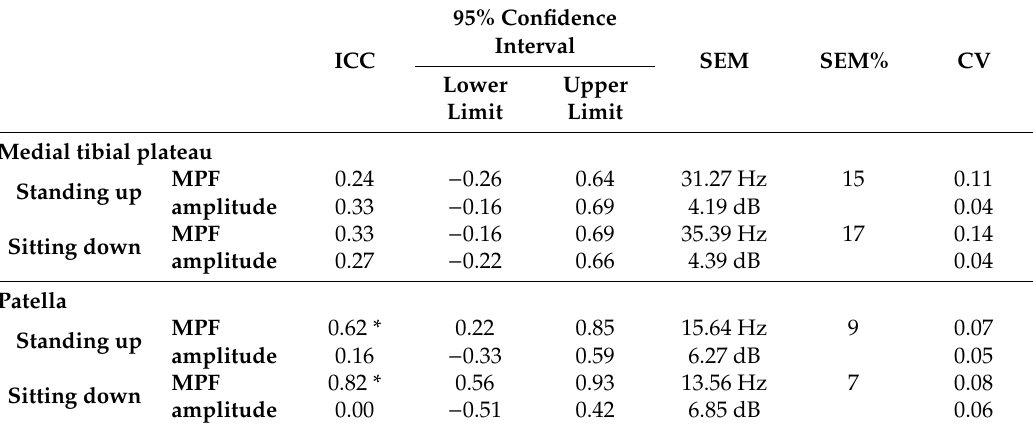
Table 2. Interday reliability at the medial tibial plateau and the patella for the standing up and sitting down movements 1